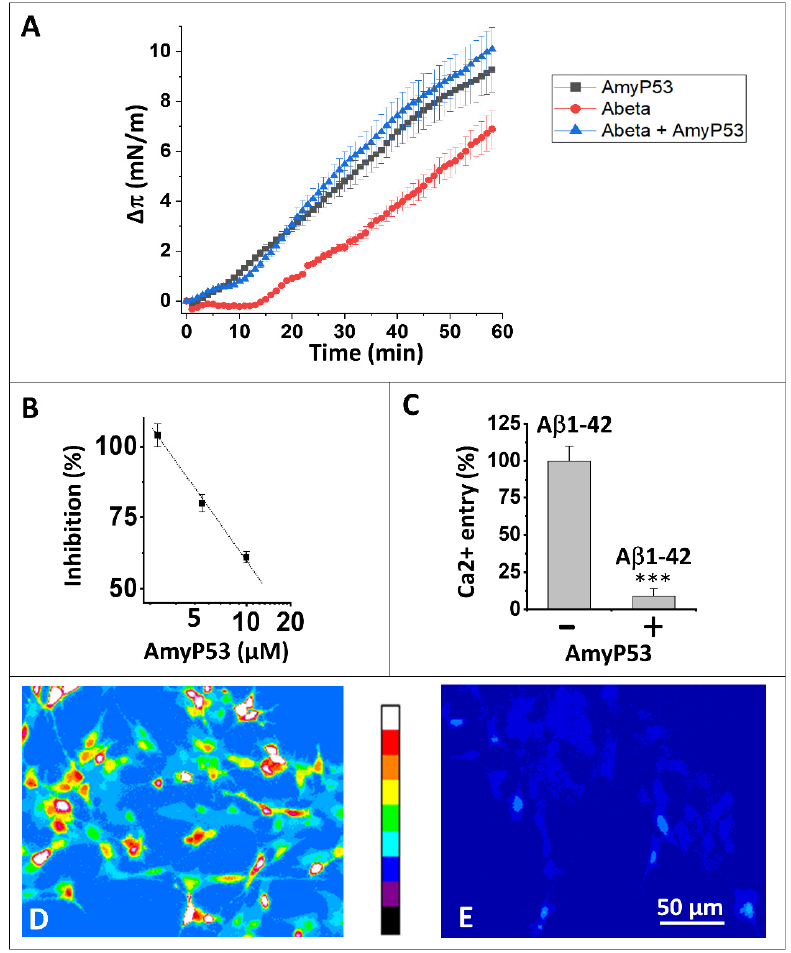
Figure 1. AmyP53 is a competitive inhibitor of A β 1–42 binding to gangliosides and subsequent neurotoxicity events. ( A ) Effect of AmyP53 (10 µ M), or A β 1–42 (10 µ M), or a mixture of both (each at 10 µ M) added underneath a ternary monolayer (POPC: GM1: cholesterol, 10: 5: 5 mol: mol: mol). The data were expressed as the surface pressure increase ( ∆ π ) ± SD (n = 3) over the time (left panel, 60 min; right panel, 20 min). ( B ) Inhibitory effect of AmyP53 for A β 1–42 binding to aged SHSY-5Y cells. ( C ) Ca 2+ fluxes induced by A β 1–42 (220 nM) added for 1 h to aged SHSY-5Y cells preloaded with Fluo-4AM, in absence ( − ) or presence (+) of AmyP53 (220 nM). Data are expressed mean ± SD of 3 distinct experiments (Student’s test ***; p < 0.05). Corresponding micrographs taken at 60 min show the effect of A β 1–42 alone ( D ) or A β 1–42 incubated in presence of AmyP53 ( E ). The images in panels ( D , E ) show pseudocolor representations of cells at the end of the incubation (warmer colors corresponding to higher fluorescence, according to the scale between the